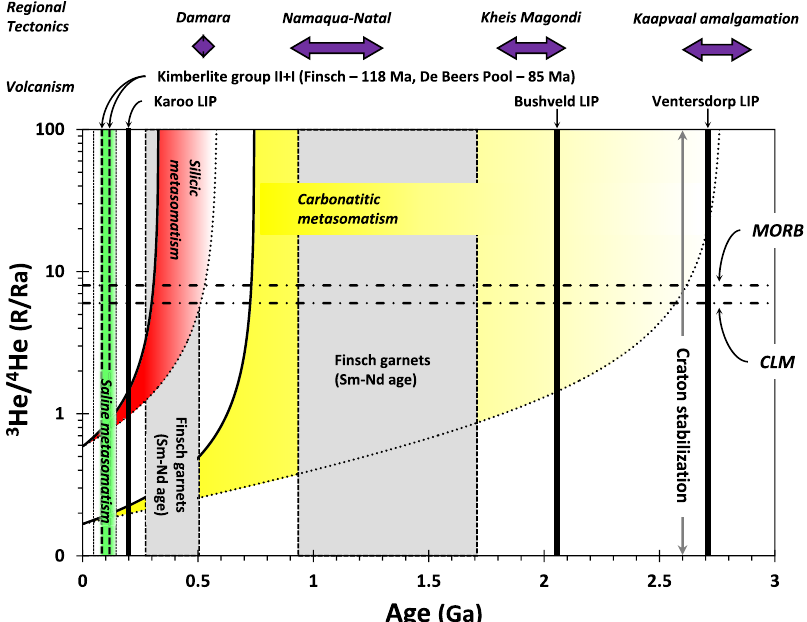
Fig. 6 Carbon- and water-rich (C-O-H) metasomatic events recorded by HDF-bearing diamonds in the southwest Kaapvaal cratonic lithosphere. U-Th- He geochronology of HDF-bearing diamonds from De Beers Pool and Finsch kimberlites reveal at least three episodes of different invading C-O-H fl uid types affected the Kaapvaal continental lithospheric mantle (CLM) during the last ~2.6 Gyr. Saline fl uids (green) controlled the metasomatism before/ during late-Mesozoic kimberlite eruptions. An earlier silicic metasomatism (red) took place during the Paleozoic between 300 – 540 Myr; a time frame that coincides with CLM enrichment events at 391 ± 120 Ma as indicated by subcalcic garnets from Finsch 74 , and overlaps the timing of the Damara orogeny (ca. 500 Ma) 76 . The oldest episode by carbonatite fl uids (yellow) could take place throughout most of the Proterozoic, following craton stabilization at 2600 Ma and until 750 Ma. This event can be related to a mantle enrichment recorded in Finsch garnets (1720 – 940 Myr) 74 and the timing of the Namaqua – Natal Orogeny between 900 and 1250 Myr 75 , but a connection to older mantle metasomatic events and large surface deformational events are also